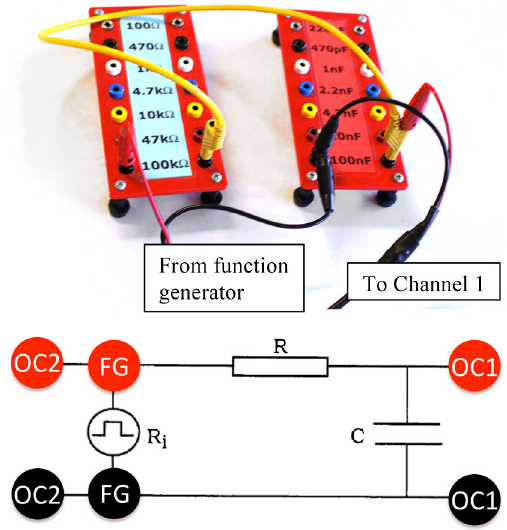
FIG. 8. A pictorial and a diagrammatic representation of the students ’ circuit after the TA ’ s second intervention. Both “ grounding ends ” of the cables were then connected to the same (equivalent) point in the circuit. FG refers to the function generator and OC1 and OC2 refer to the oscilloscope ’ s channel 1 and channel 2,